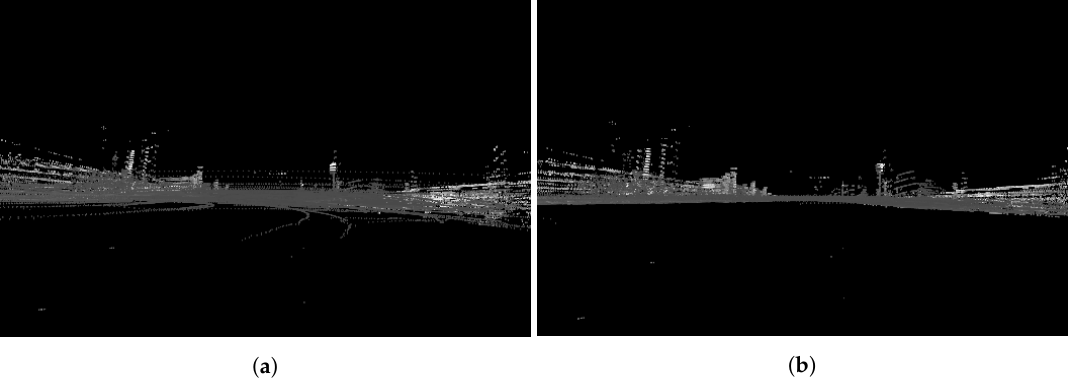
Figure 5. A cross-section of road in a LiDAR point cloud ( a ) before and ( b ) after standard iterative closest point (ICP) refinement as described in Section 3.1.4. A GPU-accelerated iterative closest point (ICP) algorithm is used in this work, which is modified to include a maximum correspondence distance threshold. Only the Neural Network (NN) points with relative displacements less than this threshold proceed to the singular value decomposition (SVD) step used to evaluate the least squares optimal rigid body transformation. The resulting registration is more robust to partial overlap of point clouds. Rather than applying iterative closest point (ICP) to point clouds of full density, random sampling of a subset of 15,000 points is applied to both the source and destination point clouds to reduce the computational load. Figure 6 describes an improved segmentation-based iterative closest point (ICP) which completes our implementation of this step of the accumulation of the dense point cloud in the radar scanning